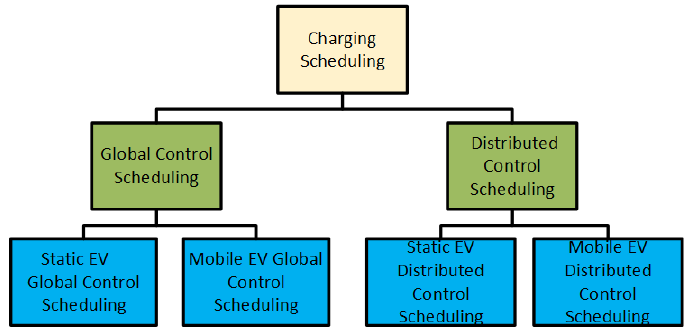
Figure 9. Classification of Charging